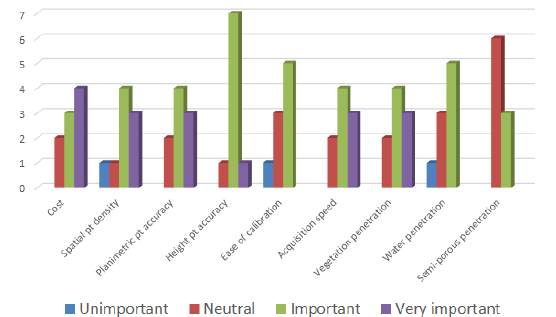
Figure 4. Important characteristics of SP/GM lidar as perceived by 20 NMCA respondents.